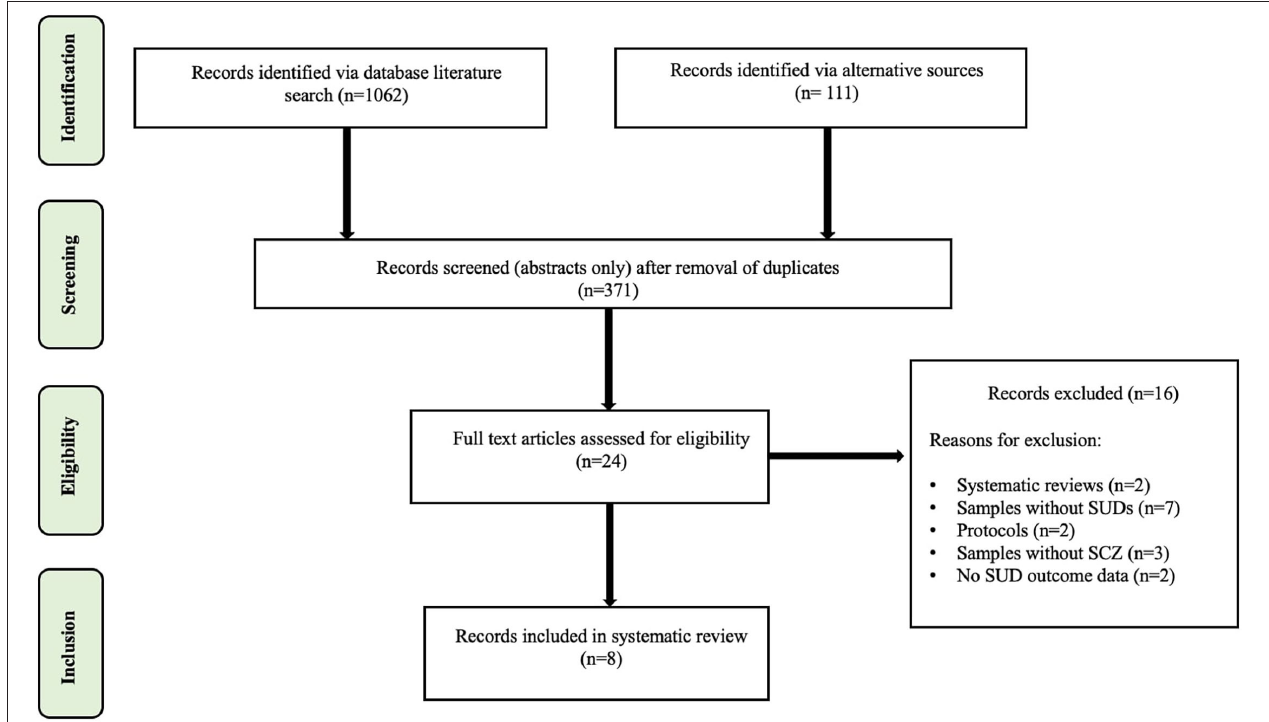
FIGURE 1 | Prisma consort